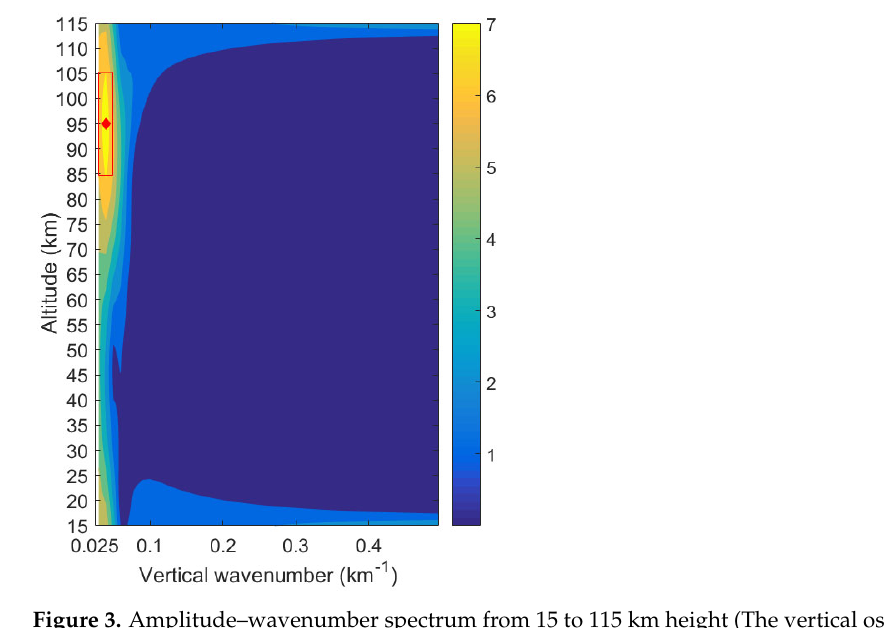
Figure 3. Amplitude–wavenumber spectrum from 15 to 115 km height (The vertical oscillation with vertical wavelength > 40 km is removed).